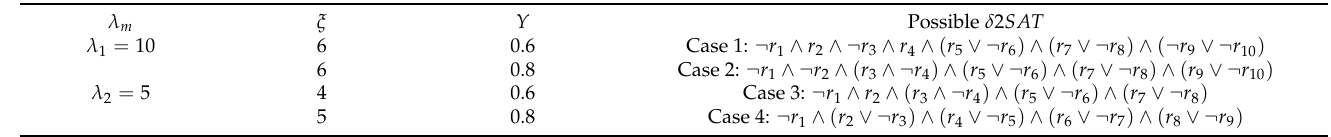
Table 1. Possible structures of δ 2 SAT when ρ = 0.7.